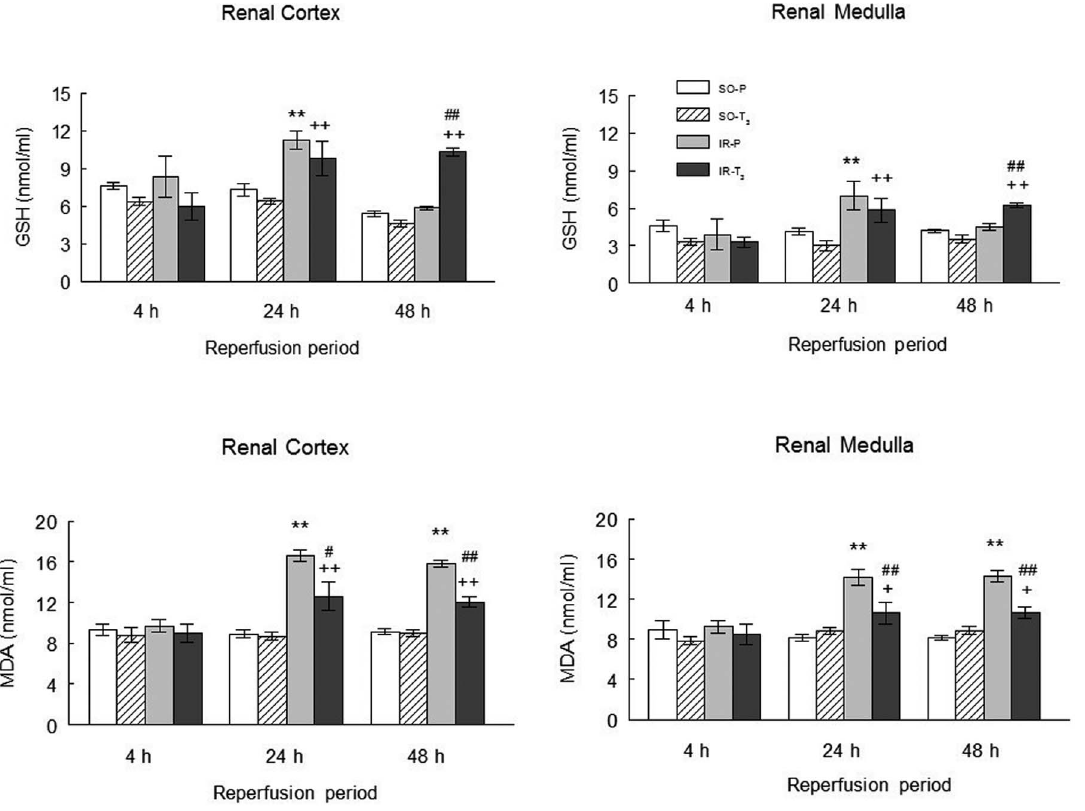
Figure 3. Renal levels of glutathione and MDA in the experimental groups. (n=10 each group): SO-P= sham-operated-placebo; SO-T 3 = sham-operated, T 3 -treated (100 m g/kg); IR-P= ischemia-reperfusion, placebo-treated; IR-T 3 = ischemia-reperfusion, T 3 -treated. Data are means 6 SEM. ** p , 0.001 versus SO-P group. + p , 0.05, ++ p , 0.001 versus SO-T 3 group. # p , 0.05, ## p , 0.001 versus IR-P group.